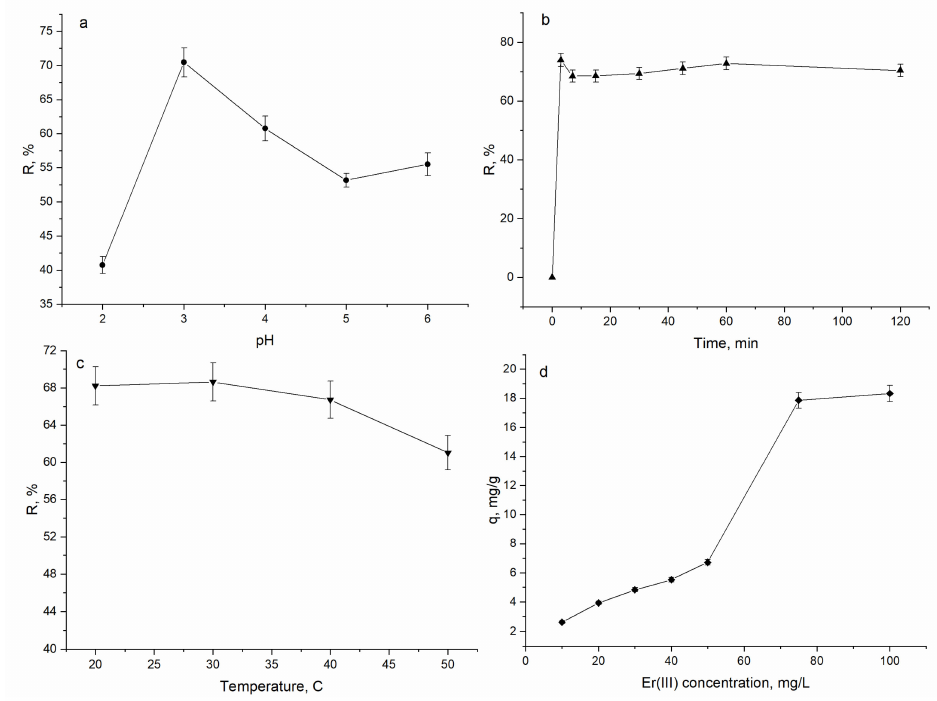
Figure 3. The effect of ( a ) pH, ( b ) time, ( c ) temperature and ( d ) Er(III) concentration on Arthrospira platensis biosorption